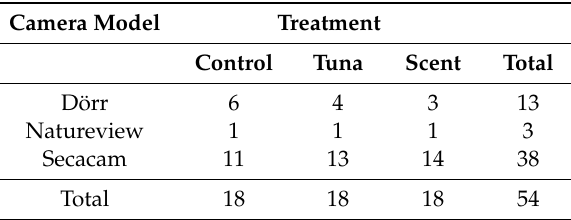
Table 1. Overview of the cameras used in the